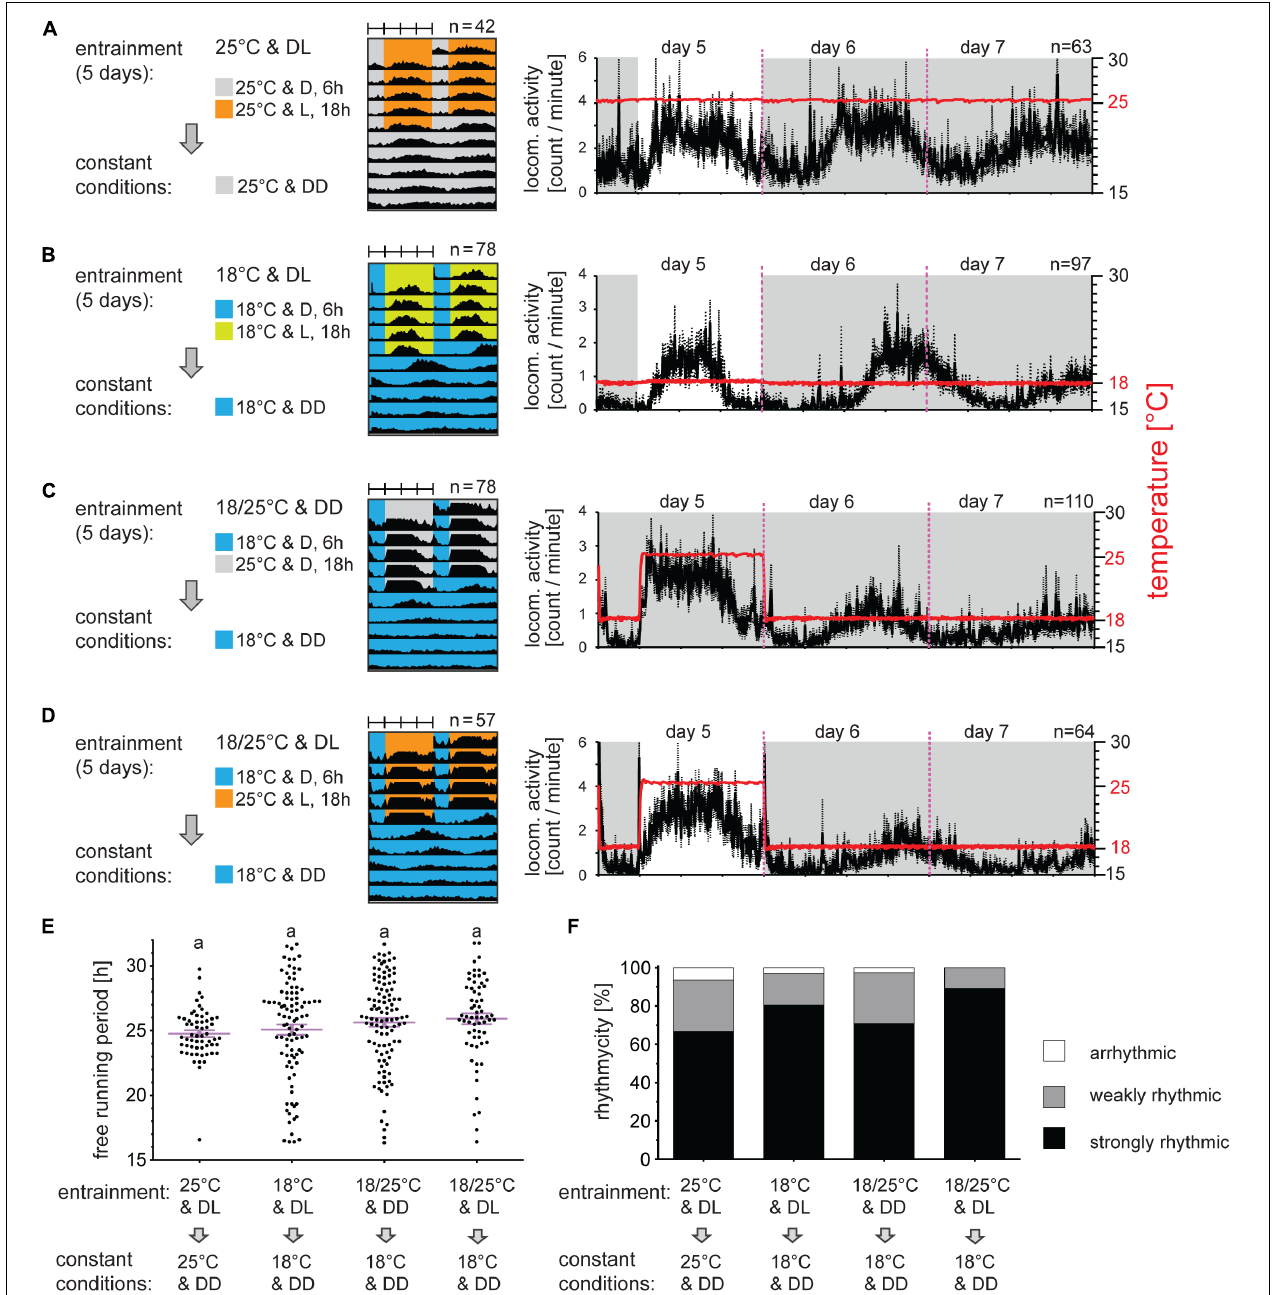
FIGURE 1 | Long periods of light and/or temperature synchronize locomotor activity in the linden bug, Pyrrhocoris apterus . Adult males raised under long photoperiod D6:L18 at 25 ◦ C were entrained for 5 days either by long photoperiods (A,B) , long thermoperiods (C) , or combination of both light and temperature (D) and released to constant dark at either 25 ◦ C (A) or 18 ◦ C (B–D ). Double-plotted actograms represent the average activity of all males rhythmic under DD conditions [see panel (F) for the rhythmicity]. Detailed activity profile is plotted from all males for day 5–7 [right panels in (A–D) ]. The actual temperature recorded during the experiment is shown in red (right y -axis). The rhythmicity under constant conditions was determined from 10 days and is presented as the free-running period of each individual male (dots) and mean ± SEM shown in magenta (E) , there is no difference in the free-running period between groups ( p > 0.05, Kruskal–Wallis). The same small letters above categories indicate no statistical difference. The percent of arrhythmic, weakly rhythmic and strongly rhythmic males is shown in panel (F) .